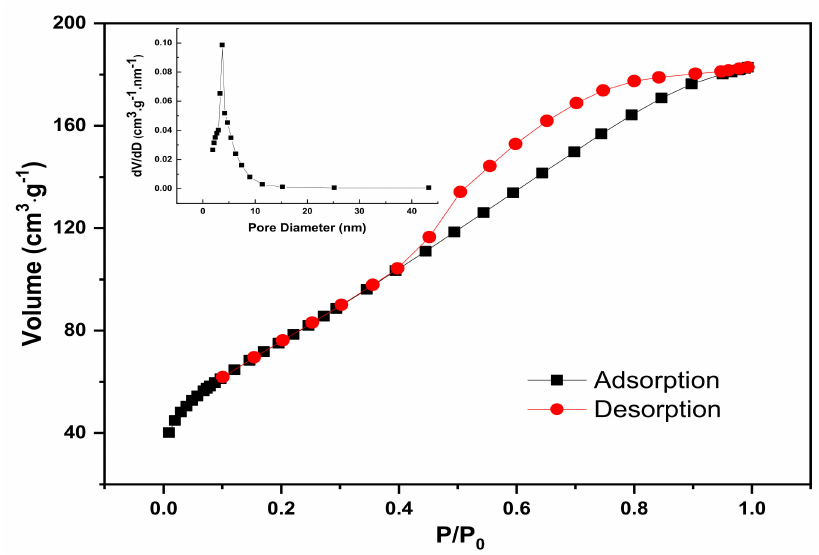
Figure 9. N 2 adsorption-desorption Isotherm and Pore size distribution curve of Fe 3 O 4 @mZrO 2 -Re (Re = Y/La/Ce).